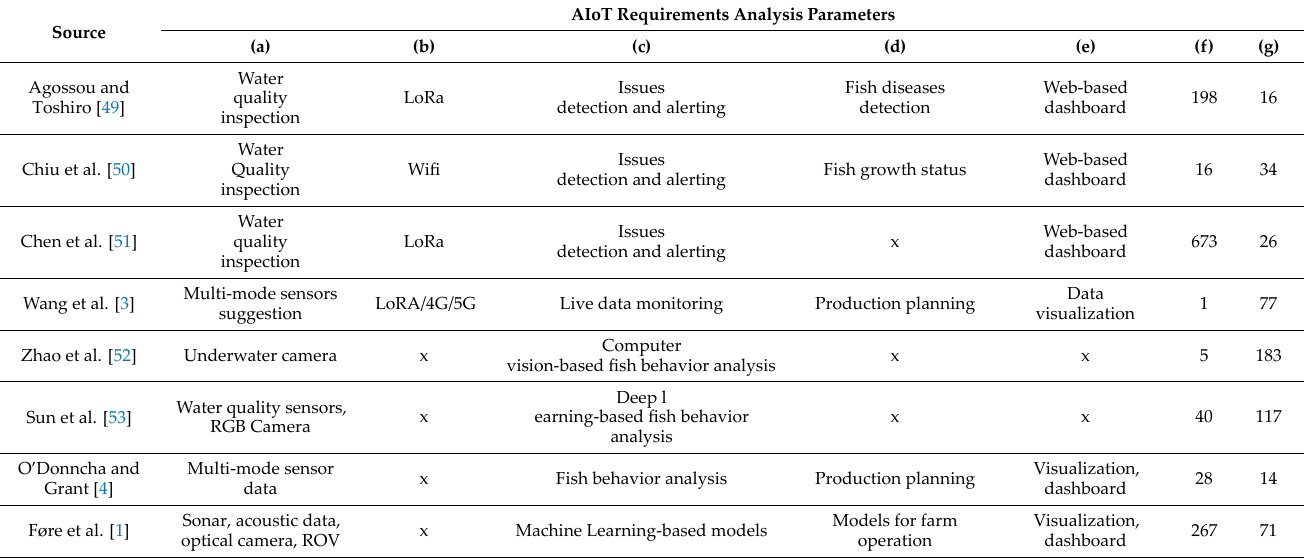
Table 15. Summary of findings regarding the construction of the AIoT for intelligent fish farming with columns (a) physical objects; (b) network communication; (c) basic service model; (d) fish farm data application; (e) user interface; (f) number of readers; (g) number of papers